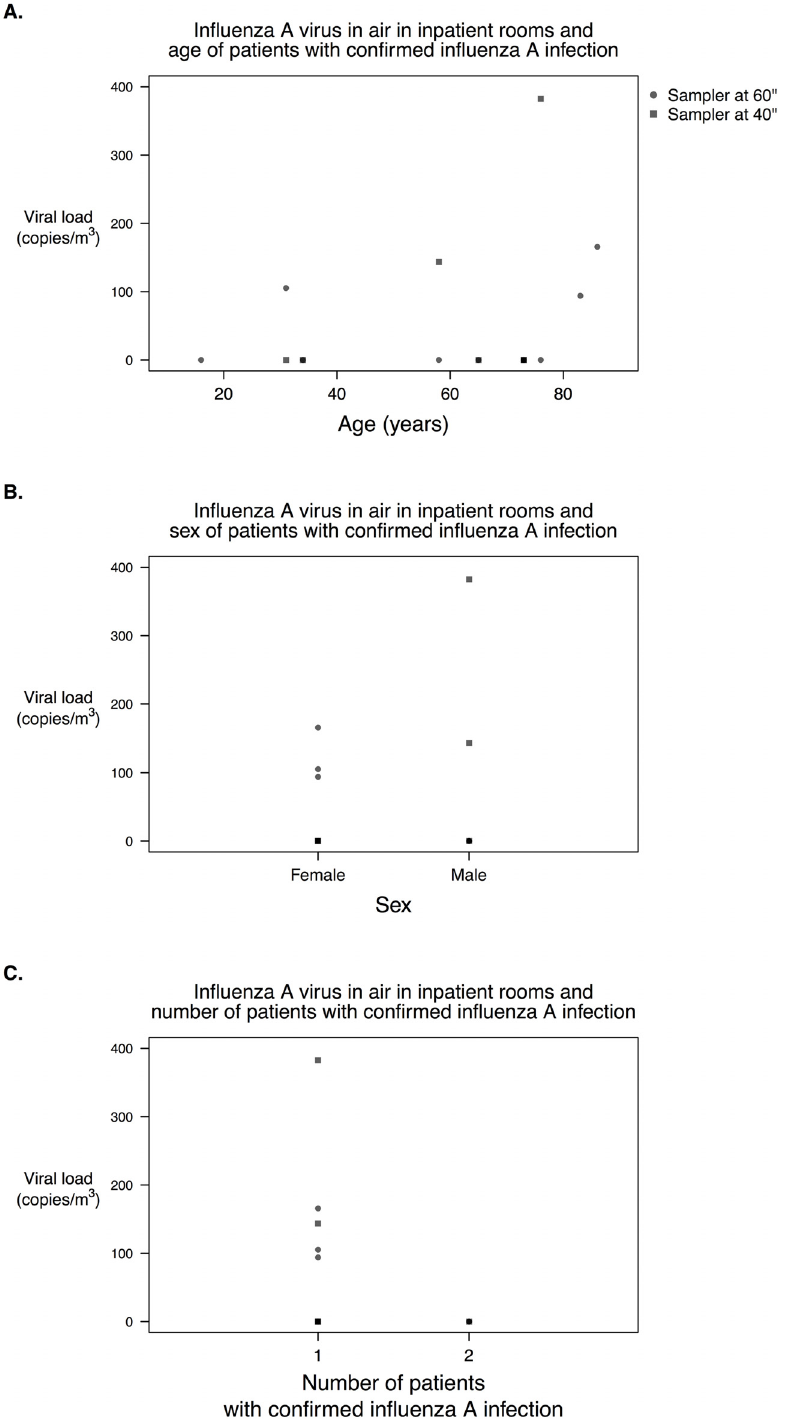
Fig 3. Scatter plots of the concentration of influenza virus RNA detected in the air versus (A) age and (B) sex of the patient with laboratory-confirmed influenza A infection, and (C) number of patients with laboratory-confirmed influenza A infection in the room. If there were more than one patient with laboratory-confirmed influenza A infection in the room, the data of the patient on the sampling bed was used. Dot indicates the concentration of RNA copies of influenza virus recovered from a sampler set at 1.5 m from the floor, and square indicates that from a sampler set at 1.0 m from the